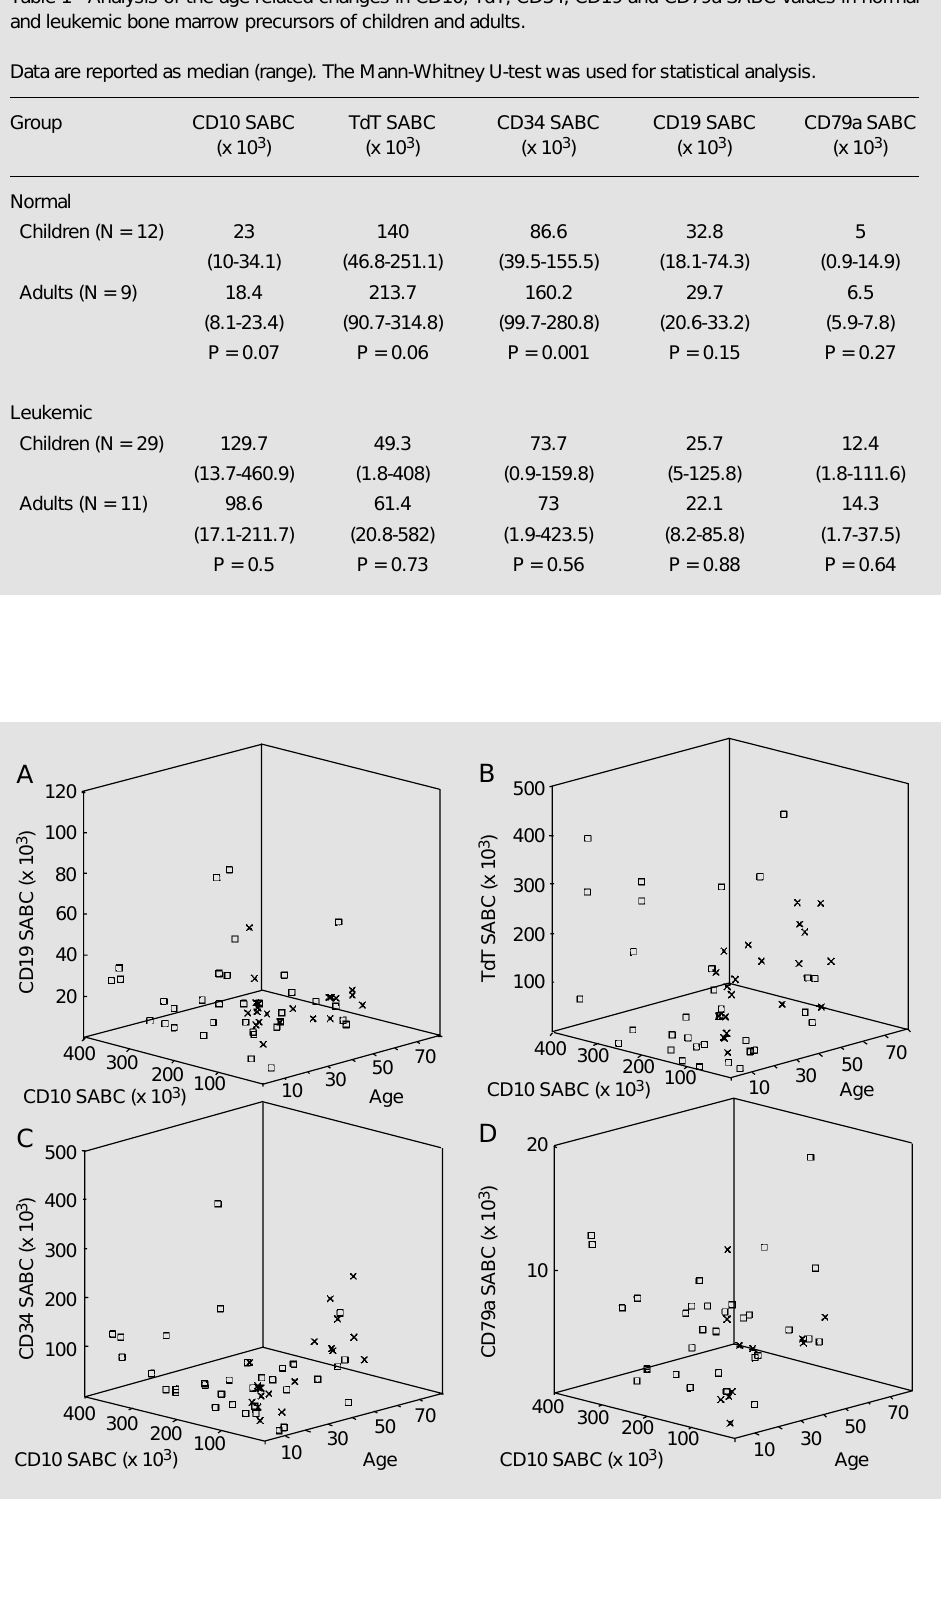
Table 1 - Analysis of the age-related changes in CD10, TdT, CD34, CD19 and CD79a SABC values in normal and leukemic bone marrow precursors of children and adults. Data are reported as median (range) . The Mann-Whitney U-test was used for statistical analysis.